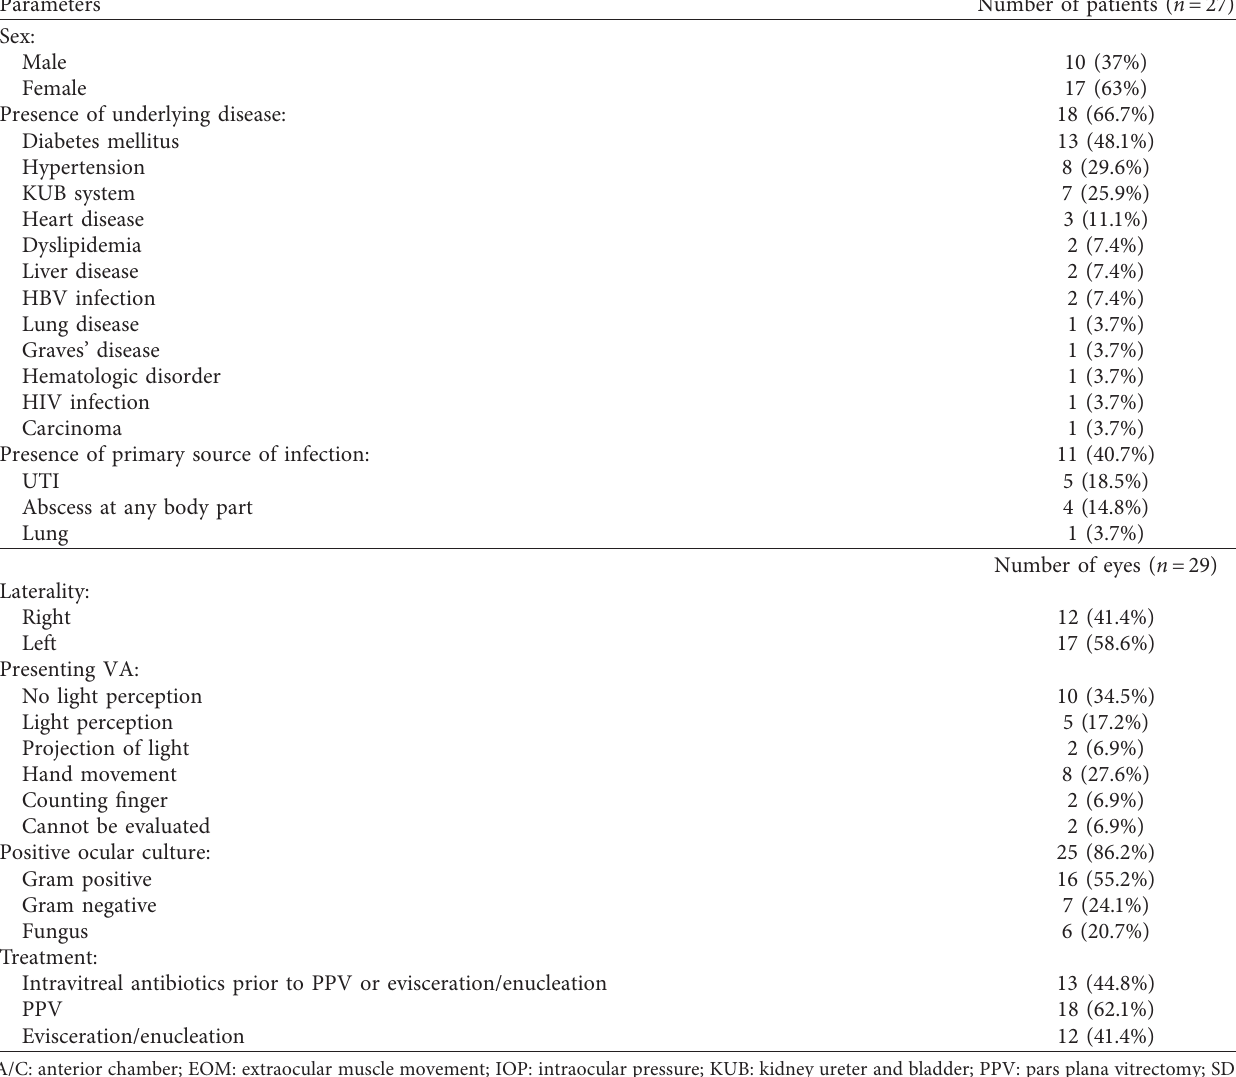
Table 1: Baseline characteristics of the patients with endogenous